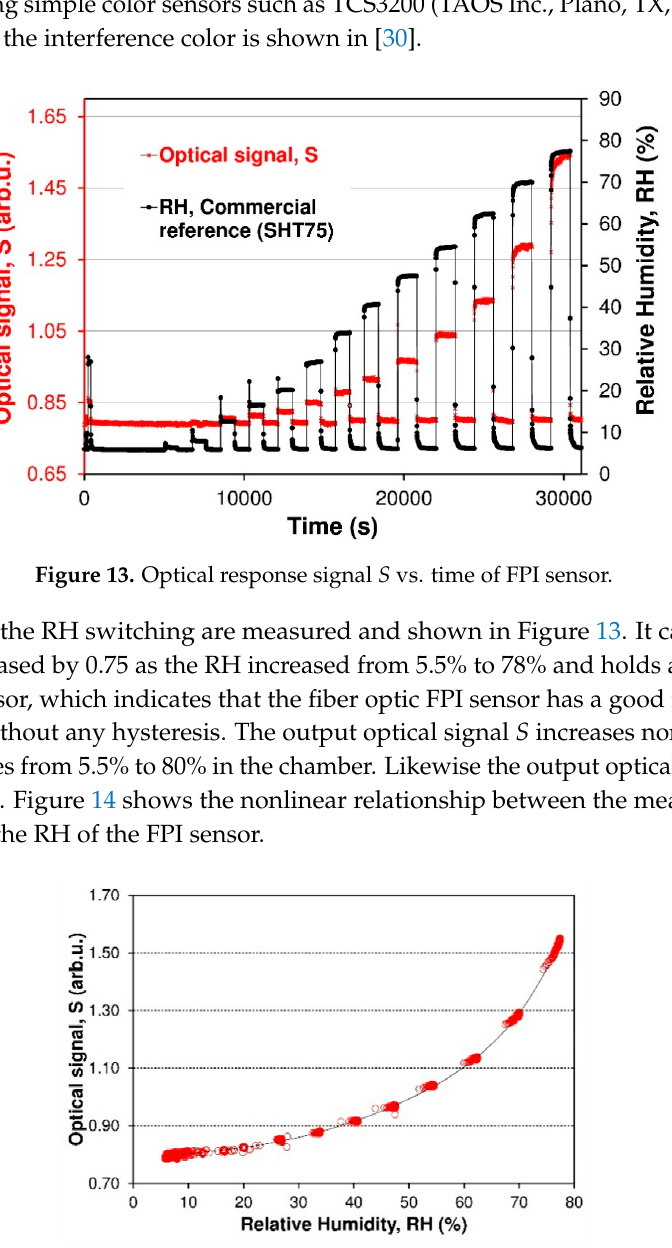
Figure 12. Normalized reflectance signals ( R FP ’( λ ) ) (at λ 1 = 539 nm—green and λ 2 = 666 nm—red) vs. time of the FPI sensor. For comparison, those raw measured optical signals are presented with response of a commercial SHT75 sensor (black line).